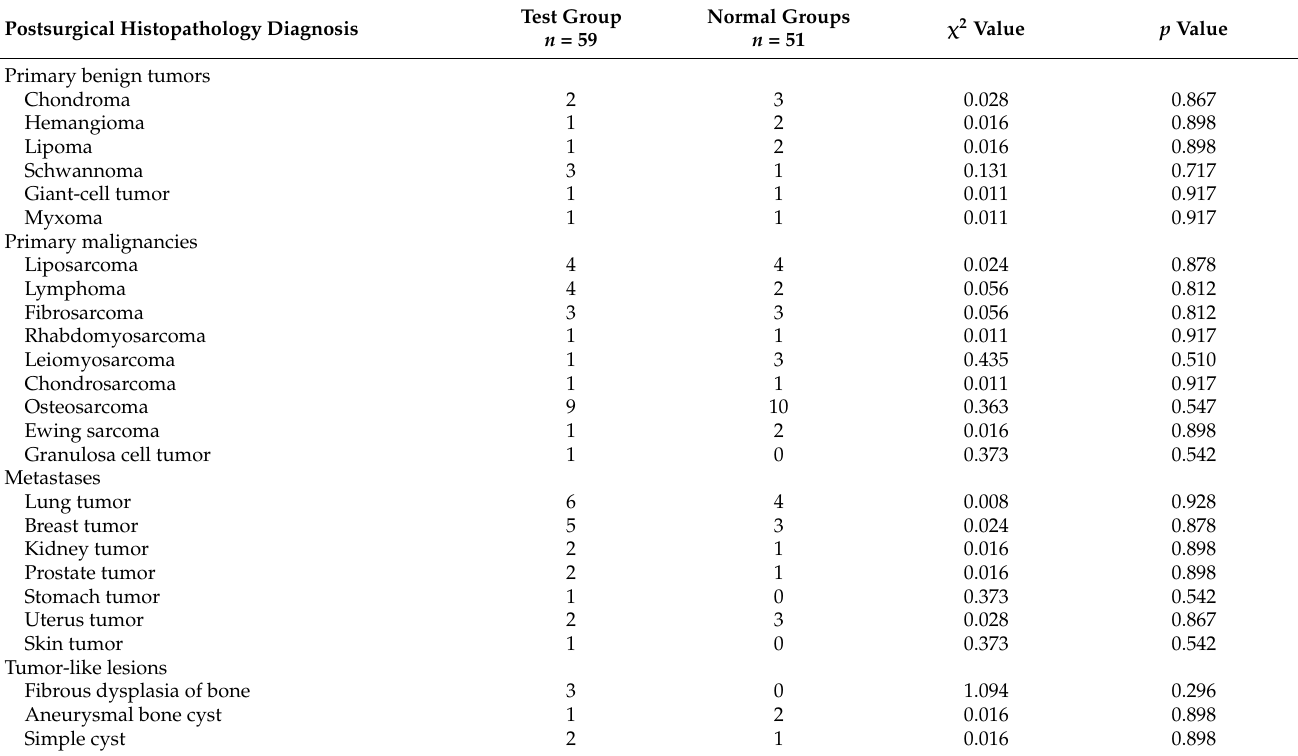
Table 2. Comparison of the pathological findings after open surgery between the test and control